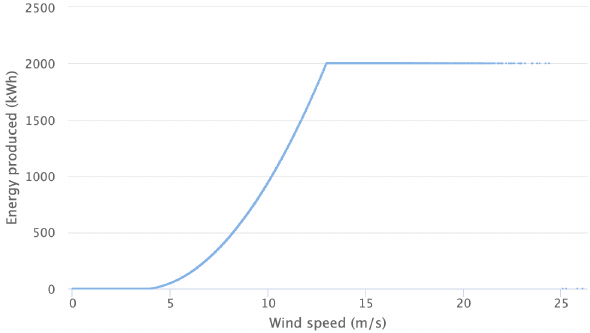
Figure 4. Power curve of a 2 MW, 95 m high wind turbine.